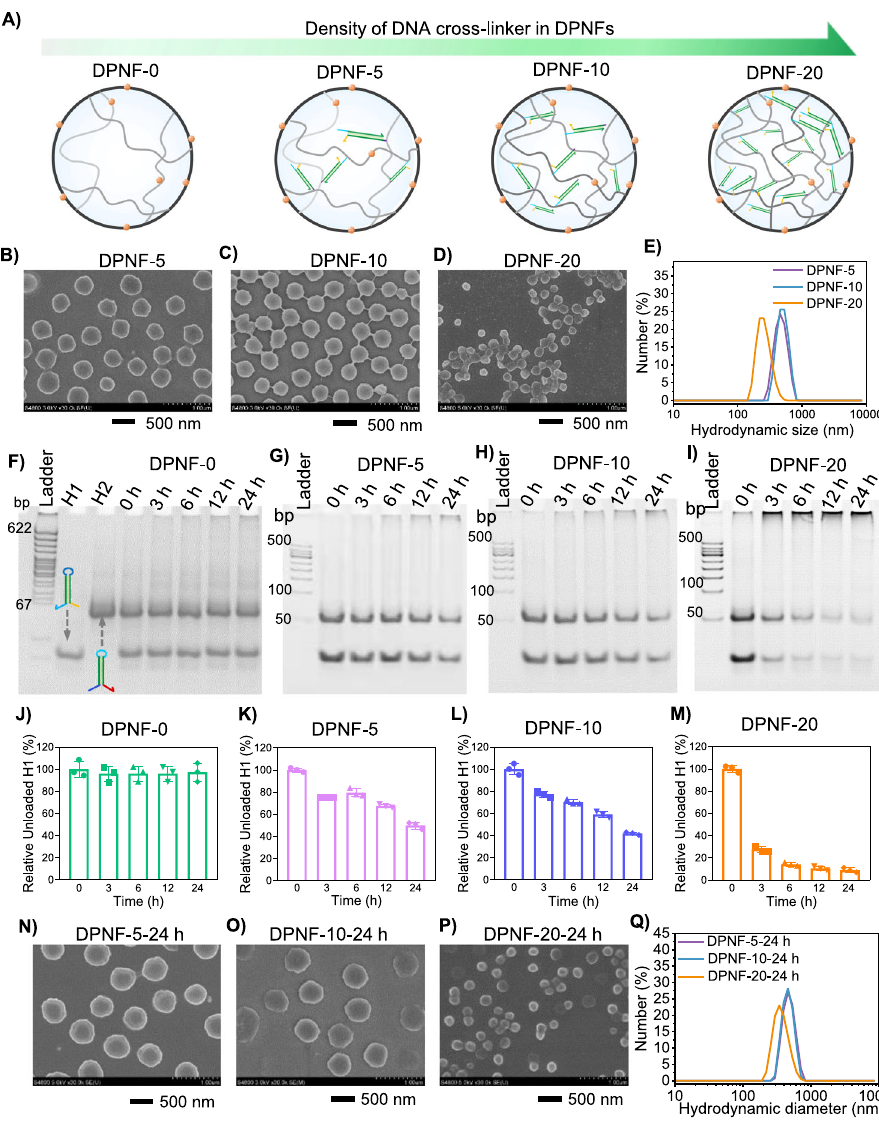
Fig. 2 Preparation of DPNF and in situ HCR of H1 and H2 in DPNF. A Schematic illustration of DPNFs with varied density of DNA cross-linkers. B – E SEM images and DLS analysis of DPNF-5, DPNF-10, and DPNF-20. F – I Gel electrophoresis analysis of HCR of H1 and H2 in DPNF-0, DPNF-5, DPNF-10, and DPNF-20. The concentration of DPNFs was 4.2 mg/ml. The concentration of H1/H2 was 3 μ M. J – M Quantitative analysis of unloaded H1 versus incubation time in gel electrophoresis shown in ( F – I ) using image J software. Error bars represent s.d. ( n = 3 independent replicates). N – Q SEM images and DLS analysis of DPNF-5, DPNF-10, and DPNF-20 incubated with H1 and H2 for 24